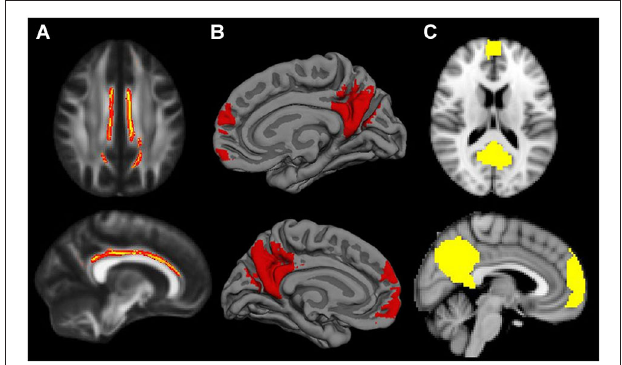
FIGURE 2 | Default Mode Network masks for the different neuroimaging modalities: (A) cingulum bundle for MD modality; (B) mPFC and posterior midline areas for GWC; (C) mPFC and posterior midline areas for VBM . When necessary masks were resampled to match template characteristics. Cingulum mask is inflated for visual